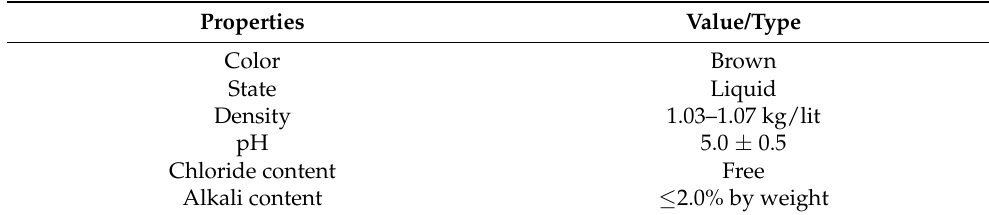
Table 3. Physical and chemical properties of the ADIUM 150.